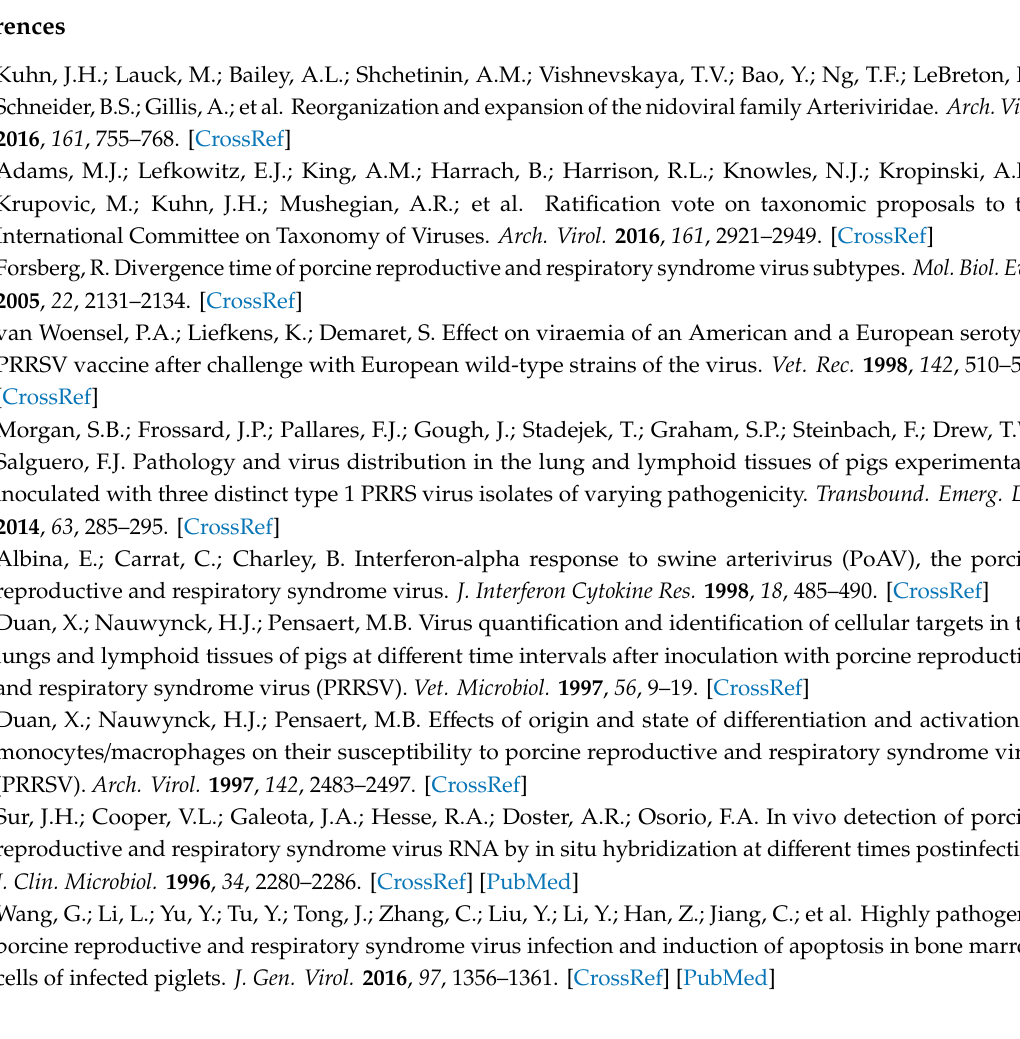
Figure S1: Elution of recombinant sISG15 from the Ni + resin column using a gradient dose of imidazole to identify the protein elution peak; Figure S2: Expression of SUMO-ubiquitin (SUMO-UB) protein. Ubiquitin cDNA was cloned from PAMs and ligated to pCold-SUMO vector for recombinant expression as a SUMO-UB-fusion protein. SUMO-UB-fusion protein was subjected to SDS-PAGE and WB using anti-His-tag Mab to confirm its expression and purity; Figure S3: Monoclonal antibody isotyping of Mab-3D5E6 specific for swine ISG15; Figure S4: Establishment of standard curve for swine ISG15 sandwich ELISA. One µ g of anti-sISG15-Mab-3D5E6 was used to coat plate wells as an ELISA capture antibody followed by blocking of wells with 5% skim milk in PBS containing 0.5% Triton X-100. Next, recombinant sISG15 was added followed by detection using 100 ng of rabbit anti-sISG15 polyclonal antibodies as detection antibodies. Interactions of rabbit anti-sISG15 polyclonal antibodies with target proteins were detected using HRP-conjugated goat anti-mouse IgG antibodies and visualized using TMB substrate; Figure S5: Cell viability assay for PAMs treated with sISG15. PAMs were seeded into 24-well plates at a density of 5 × 10 5 cells / well and cultured for 6 h. Then, recombinant expressed sISG15 at the indicated concentration was used to treat PAMs for another 24 h. Cell viability of sISG15 treated PAMs were evaluated using the CellTiter-Glo ® Luminescent Cell Viability Assay Kit. All experiments were repeated at least three